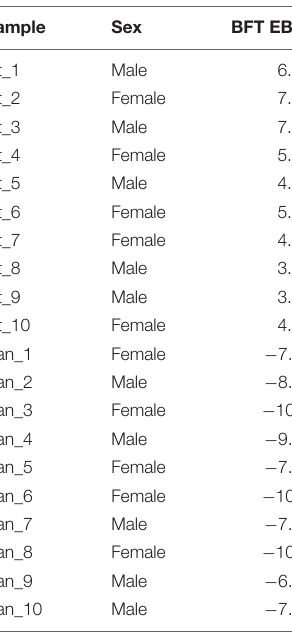
TABLE 1 | Summary of RNA-seq